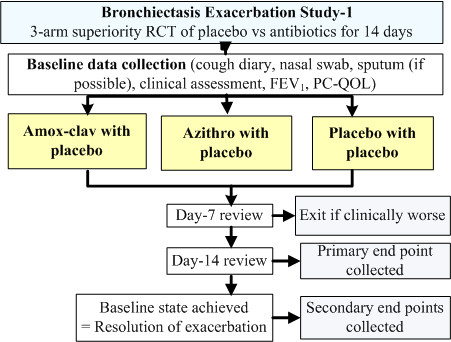
Overall schematic study design. Amox-clav: amoxicillin-clavulanic acid; azithro: azithromycin.